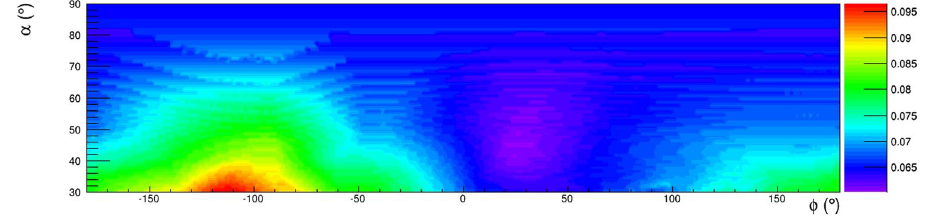
Figure 13. The expected transmission. The drawing was obtained using the software root .